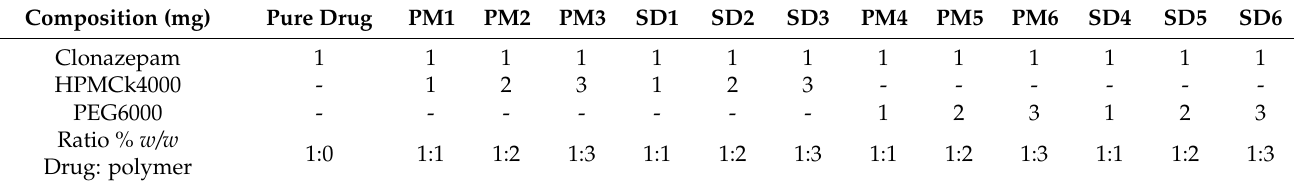
Table 1. Composition of Clonazepam, different physical mixtures, and solid dispersions. Composition